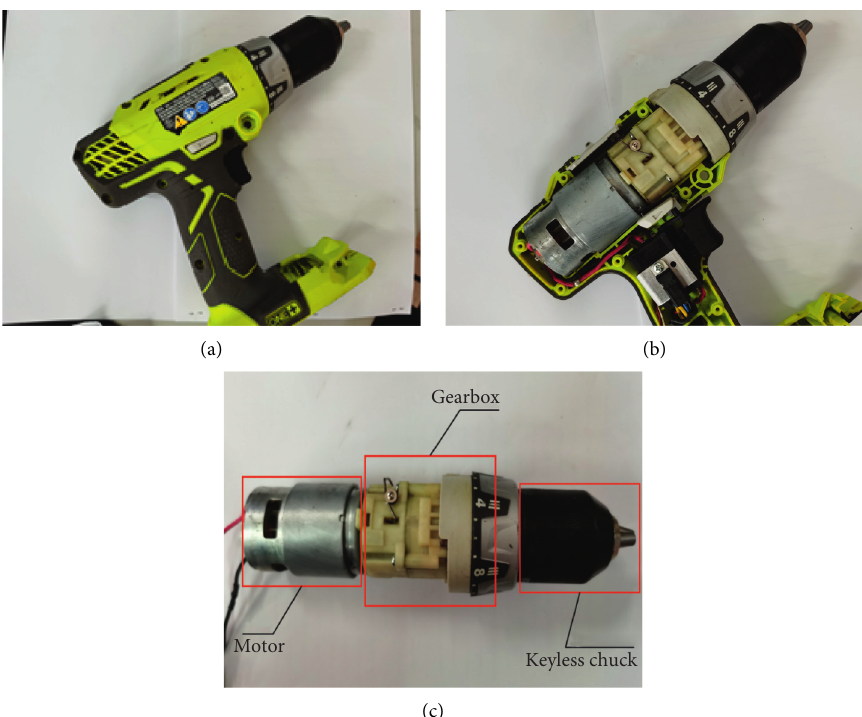
Figure 1: (a) Healthy electric impact drill (EID); (b) internal view of a healthy EID; (c) internal composition diagram of an EID, with the three main components (motor, gearbox, and keyless chuck)